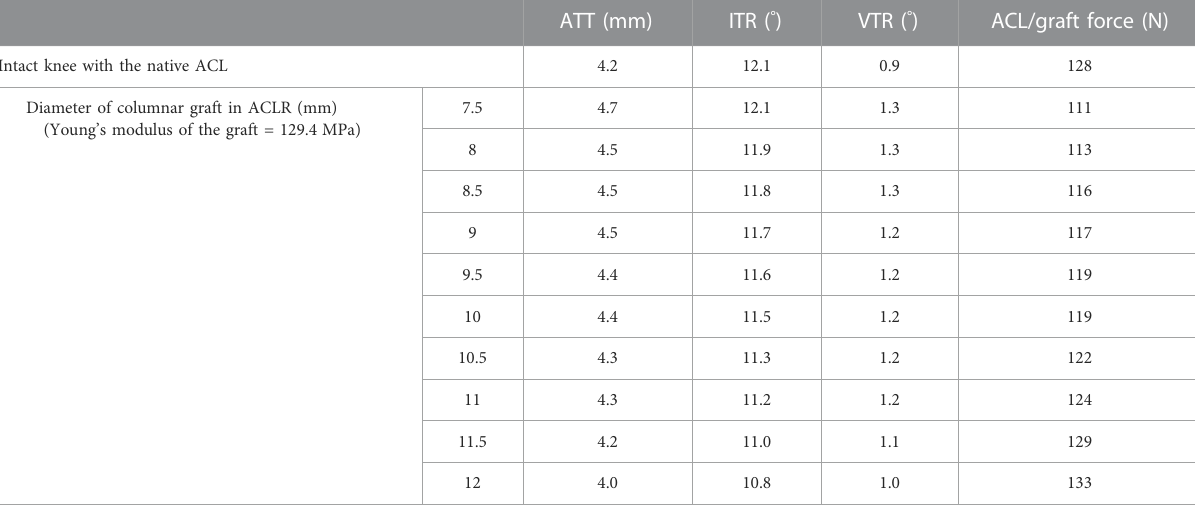
TABLE 1 ATT, Anterior tibial translation; IRT, internal tibial rotation; VTR, valgus tibial rotation and ACL/graft force in the intact knee and knee after ACLR using columnar grafts of different